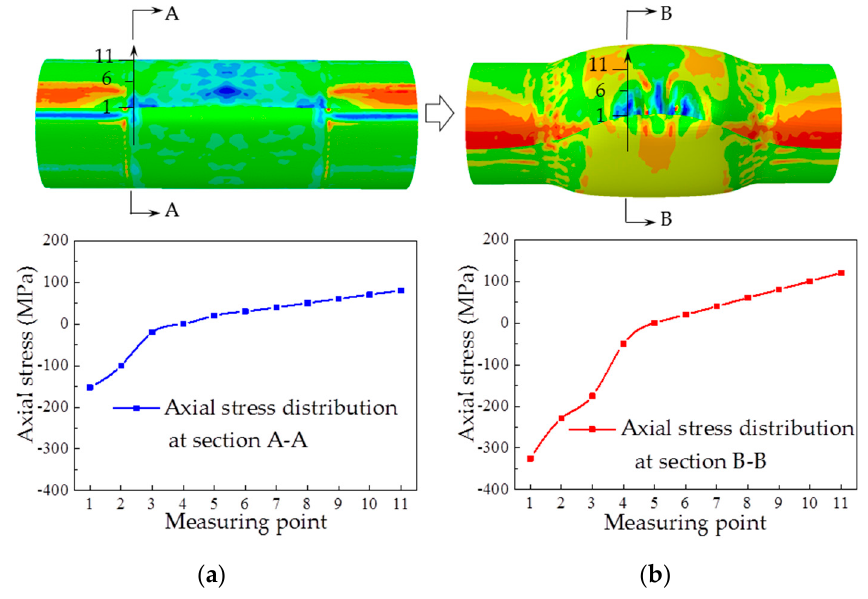
Figure 17. Axial stress distribution at the outer layer of overlap. ( a ) p = 2.0 MPa; ( b ) p = 5.0 MPa.